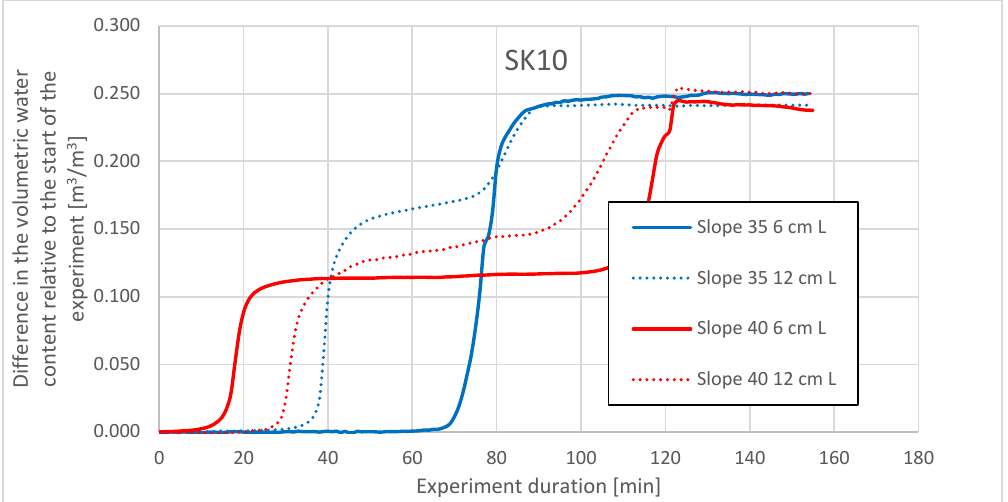
Figure 10. Comparison of the changes in the volumetric water content at different parts of the ex- perimental model for the SK10 experiment. Locations of measurement points are shown in Figure 2.